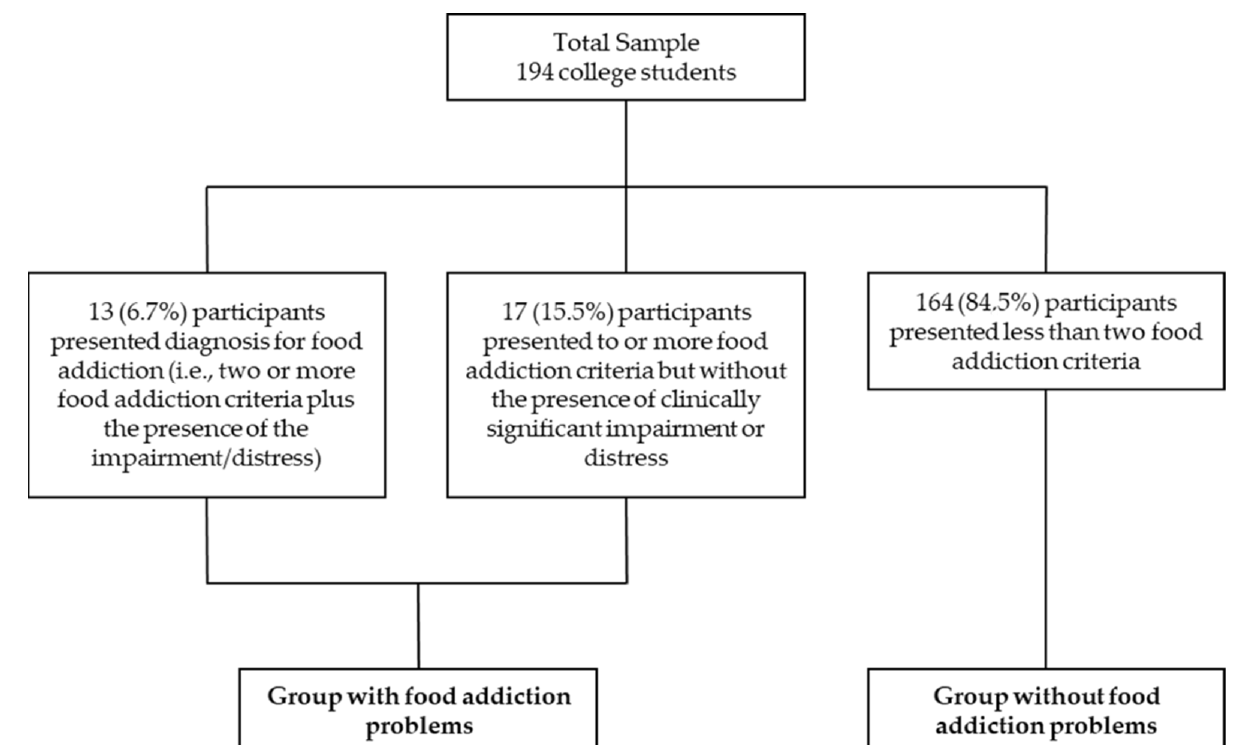
Figure 1. Flow diagram representing the division between the “Group with food addiction problems” and the “Group without food addiction problems” in accordance with P-YFAS 2.0.